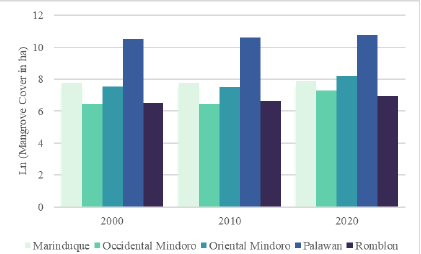
Figure 2. Mangrove cover of Region IV-B provinces of 2000, 2010, and 2020 on an ln scale and in hectares.